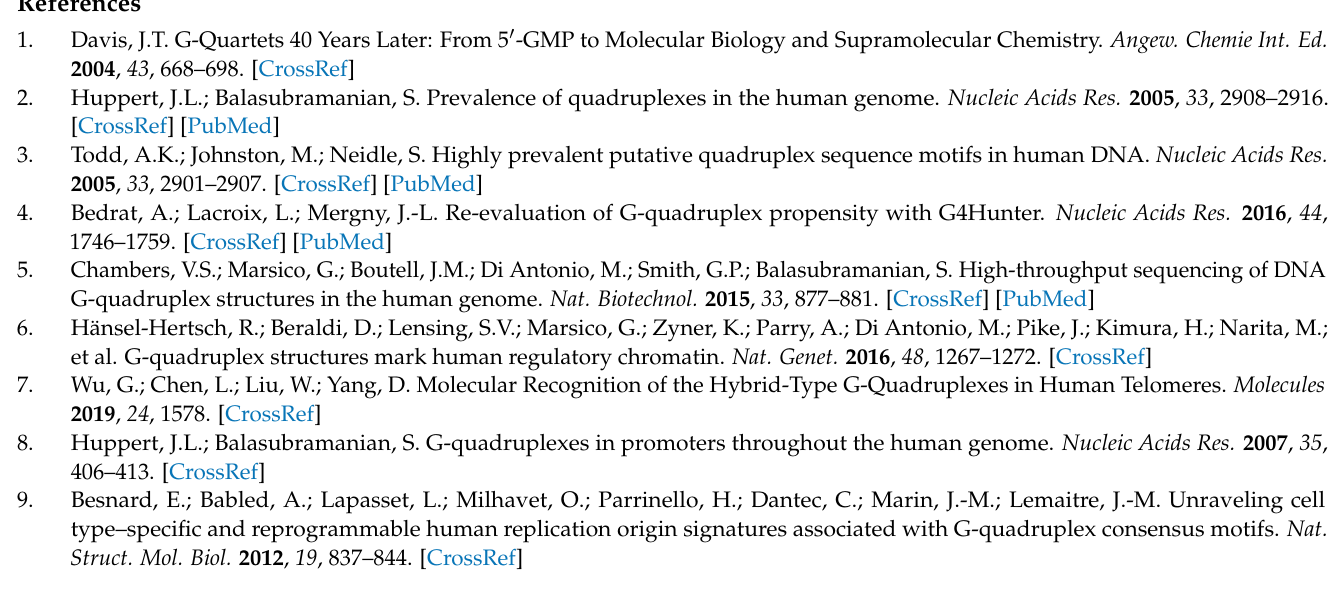
Scale bar: 5 µ m. Figure S10. HMOX1 does not bind directly to DNA. ( A ) Input step of ChIP protocol; chromatin isolated from iPSC Hmox1 +/+ treated (or not) with 2 µ mol/L hemin and incubate for 4 h. n = 3 ( B ) Agarose gel after immunoprecipitation, reversal of cross-links and DNA purification. Figure S11. G-quadruplex oligonucleotides do not affect Hmox1 expression and free heme levels in HEK293T cells. ( A ) HEK293 cells transfected with 18 nmol/L ckit87up oligonucleotides show enhanced N- methylmesoporphyrin IX fluorescence, N = 3, * p < 0.05, One-Way ANOVA with Bonferroni post hoc test ( B ) Ratio of green (eGFP) to red (mKATE2) fluorescence of cytoplasmic and nuclear heme sensors in HEK293T cells transfected with G4-forming oligonucleotides or control DNA and treated with hemin. Green fluorescence of eGFP is quenched by heme. N = 3, bars show average ratio + standard deviation ( C ) Transfection with ckit87up oligonucleotides does not affect Hmox1